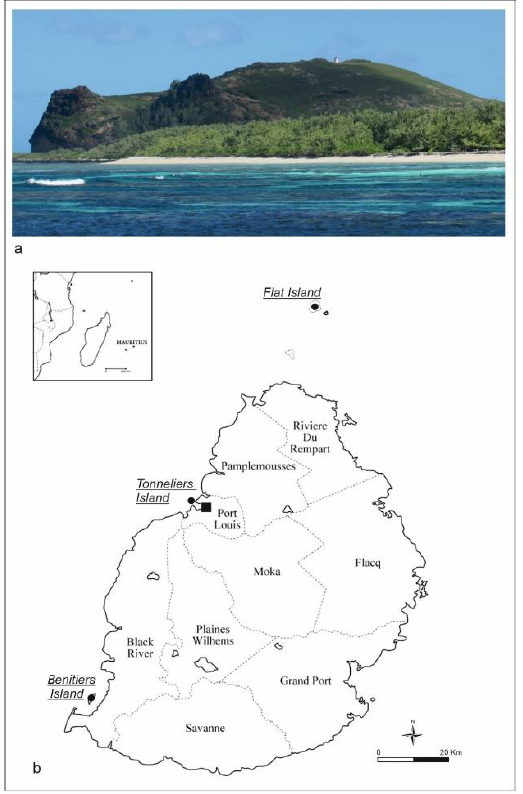
Figure 1. Flat Island—Mauritius: ( a ) The island from the southeast with the lighthouse at the highest elevation; ( b ) location of quarantine islands used during the 19th century in Mauritius.